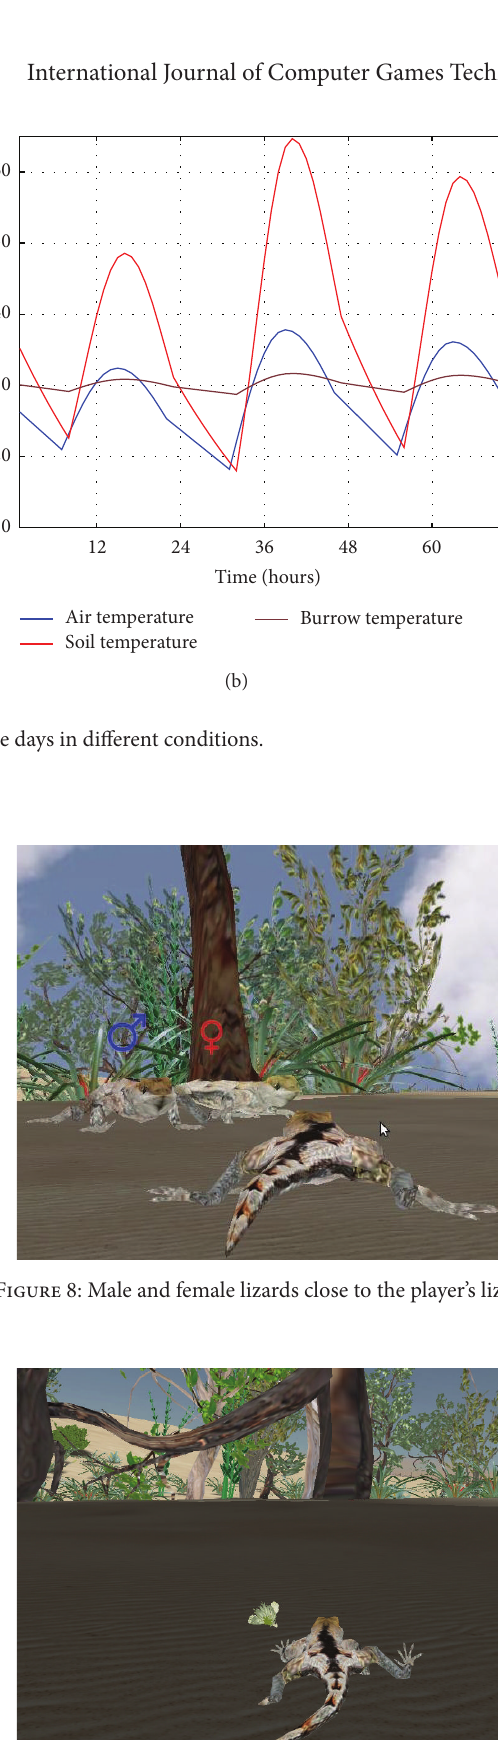
Figure 9: Lizard and plants in the dunes. Note the shadows under the plants and the white flower on the floor in front of the